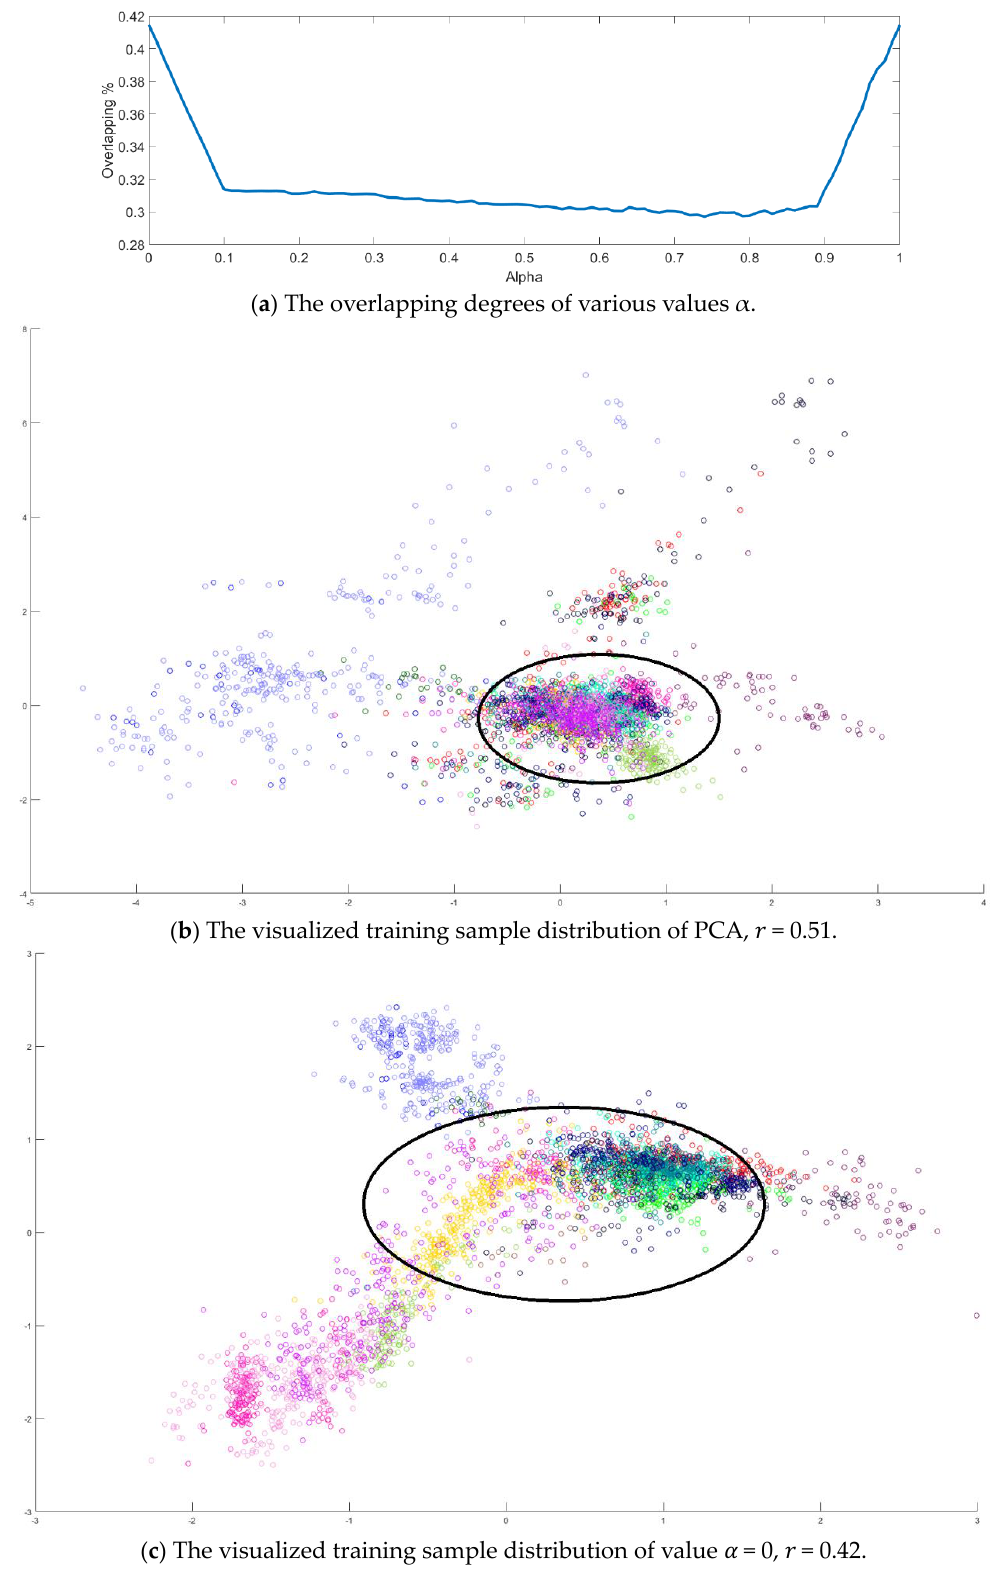
Figure 9. Dataset IPS: ( a ) False color image; ( b ) Class label map.